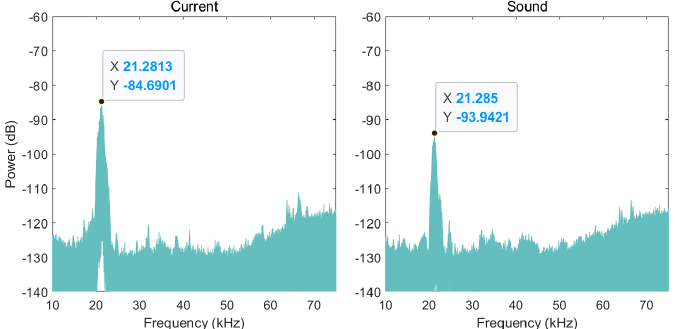
Figure 11. Spectrum of simultaneously collected current and sound